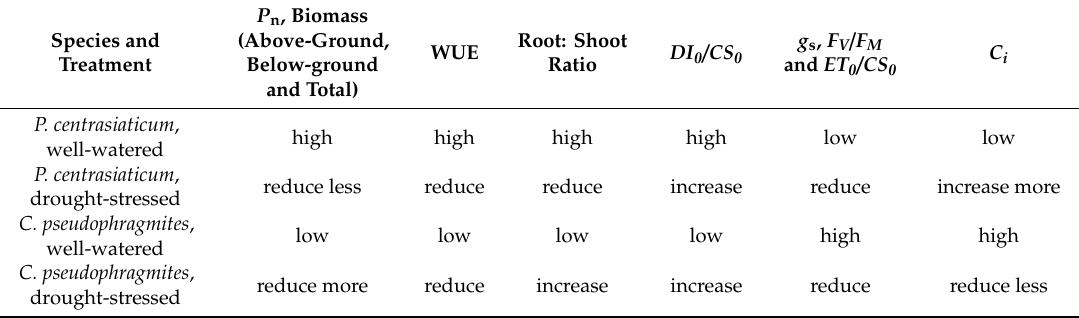
Table 2. Similarity and di ff erentiation of net photosynthetic rate ( P n ), stomatal conductance ( g s